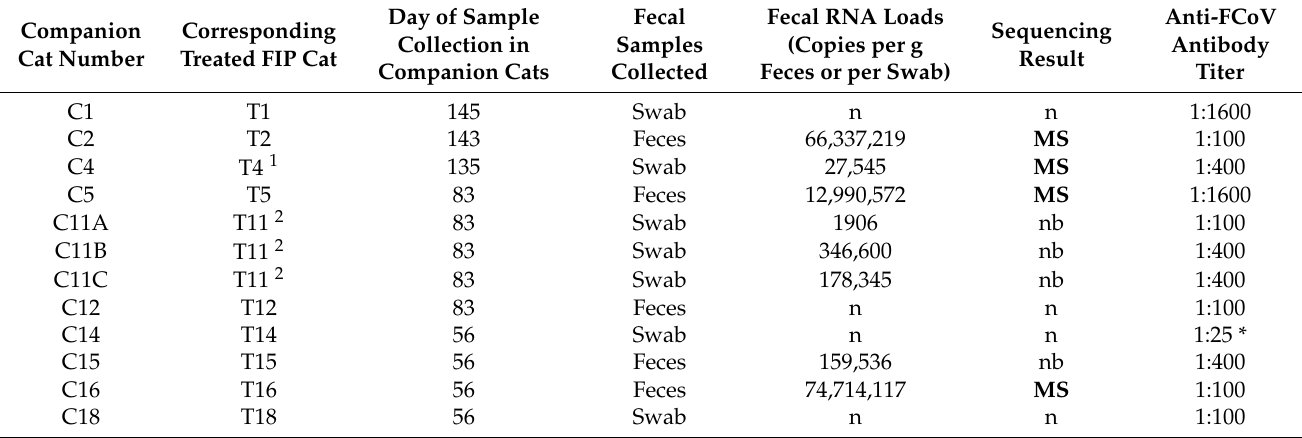
For better comparison, fecal swab samples are highlighted in gray. Bold: sequenced samples. 1 T4 showed reoccurrence of fecal shedding on day 83. 2 T11 was one of two cats that showed new appearance of fecal